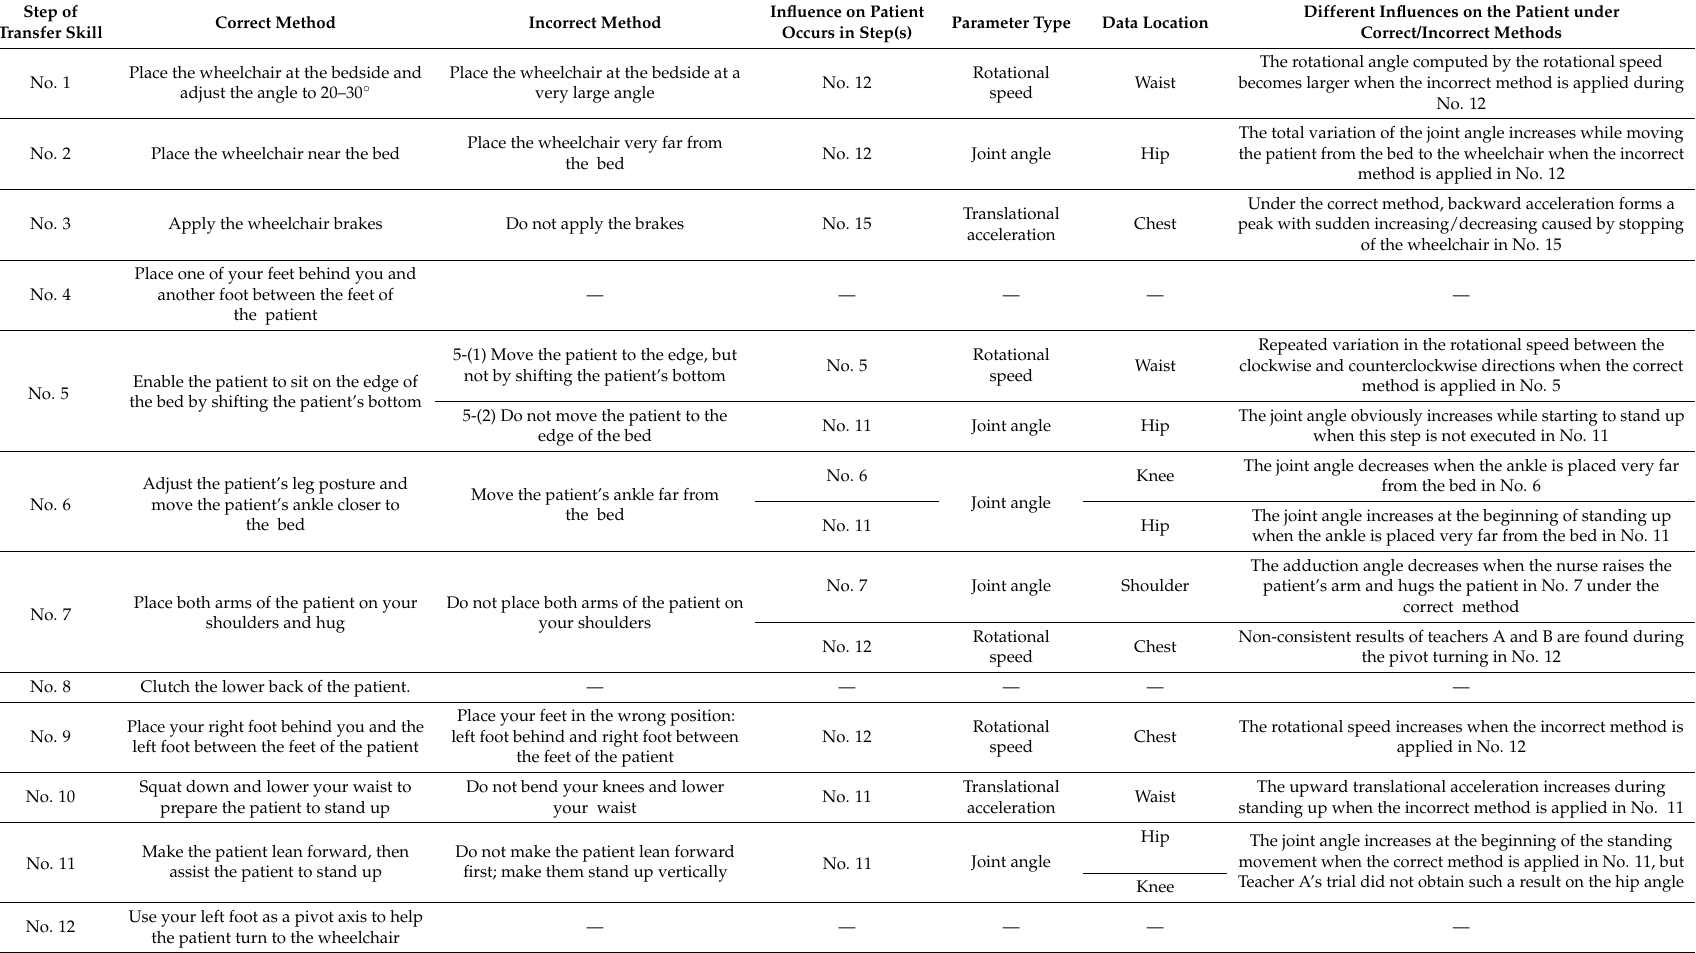
Table 1. Check list of patient transfer